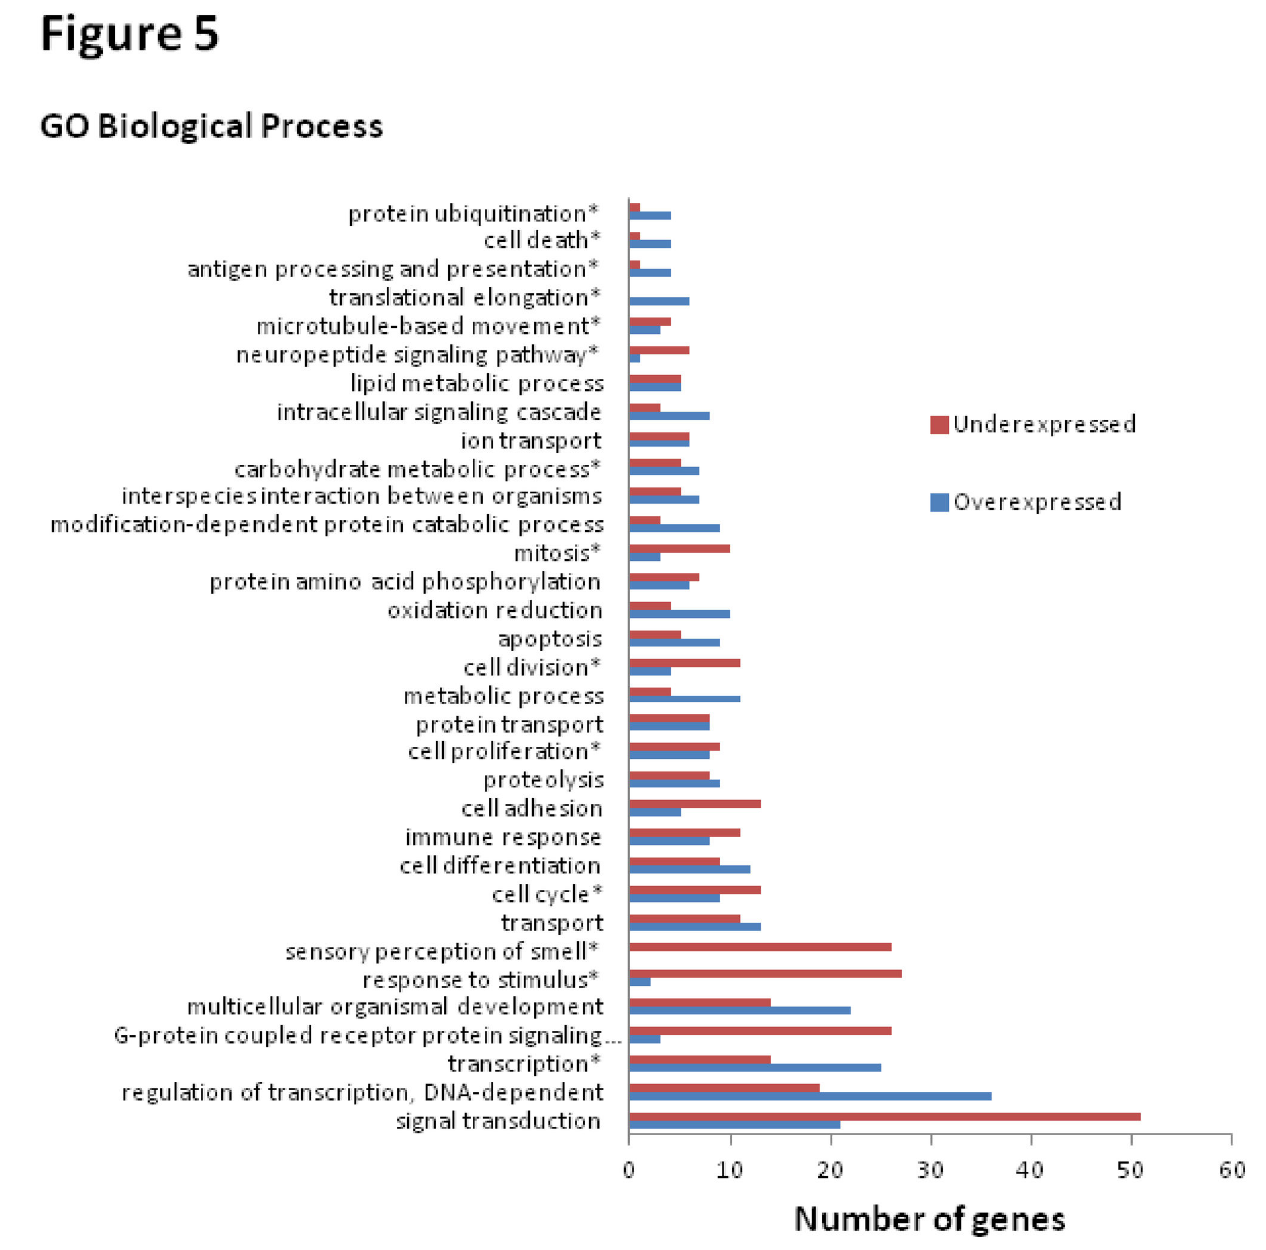
Figure 5. Gene Ontology (GO) categories denoting Biological Process (BP) information for differentially expressed genes. Information is derived using Onto-Express (http://vortex.cs.wayne.edu/projects.htm). Diagram shows the number of under- and over-expressed genes for GO BP. The BP marked with stars denotes a statistically significant group ( p <0.05). Only the groups with a gene number ≥ 5 are